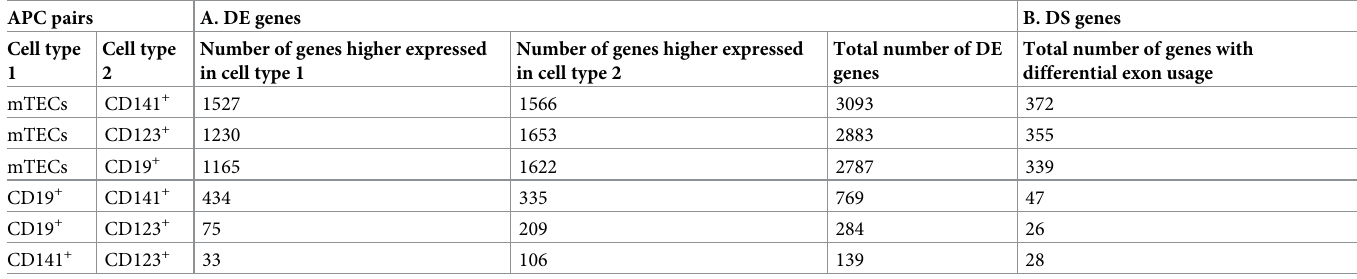
Table 1. Pairwise comparison of A. differentially expressed (DE) genes (log 2 fold change > 1; FDR P-value < 0.05) and B. differentially spliced genes (FPKM > 1; FDR P-value < 0.05) in the four thymic APCs. APC pairs A. DE